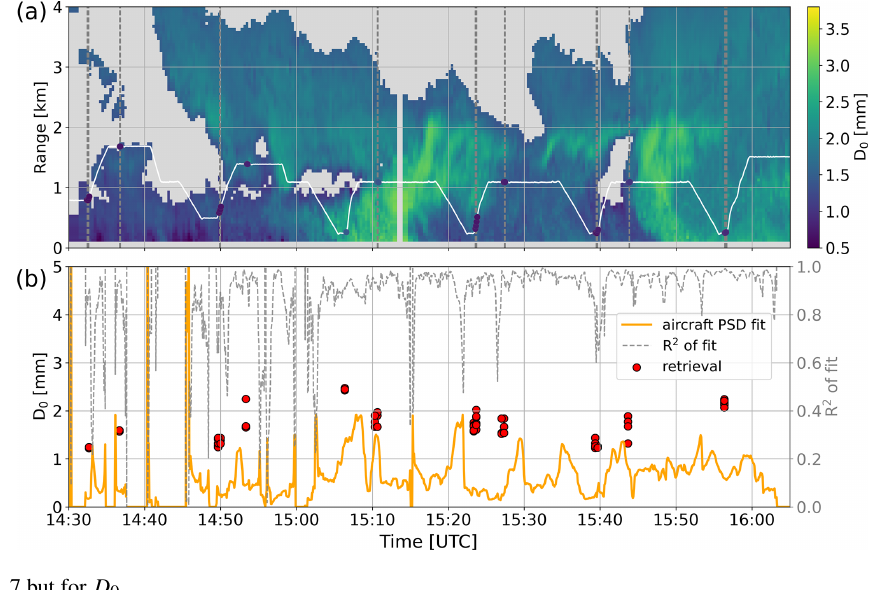
Figure 9. As for Fig. 7 but for D 0 .